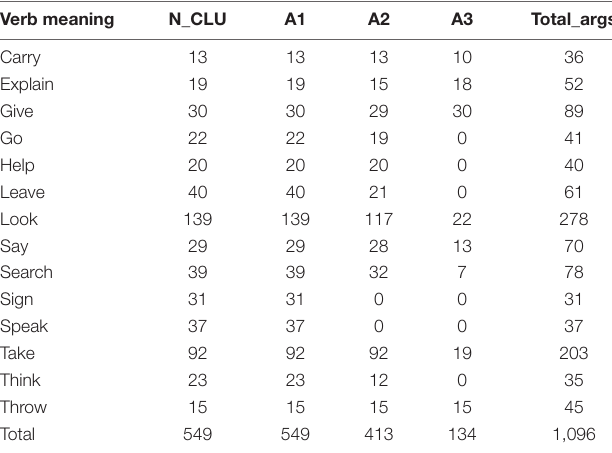
TABLE 3 | Frequency of verb meaning and